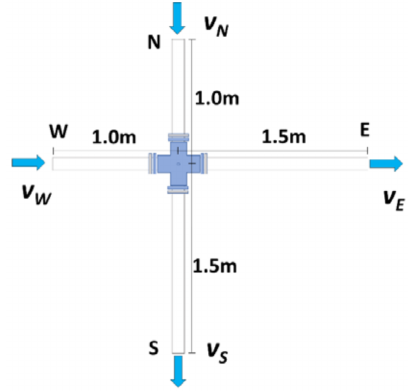
Figure 1. Cross-junction boundaries. The distances correspond to the pressure registration